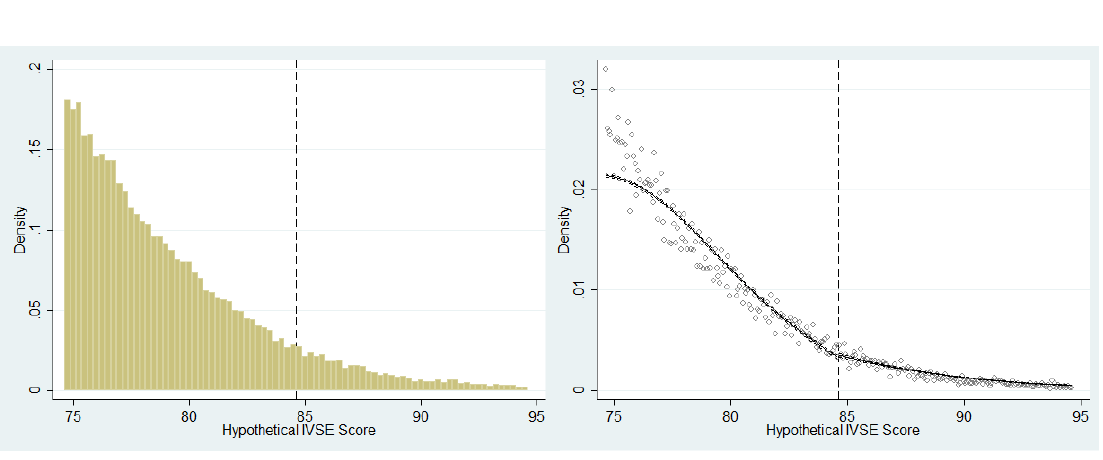
Figure 2: Hypothetical IVSE Density & McCrary Test (Year